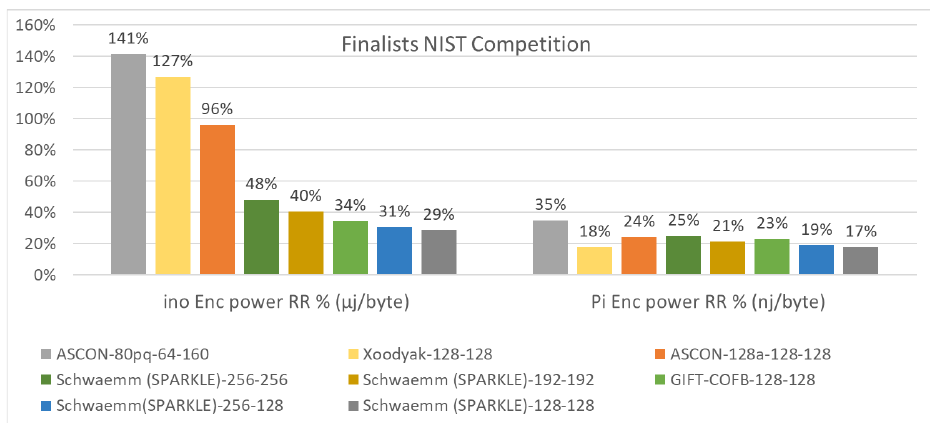
Figure 28. Best 8 Algorithms of NIST finalists in ENC energy with respect to RR % for both UNO and Pi.